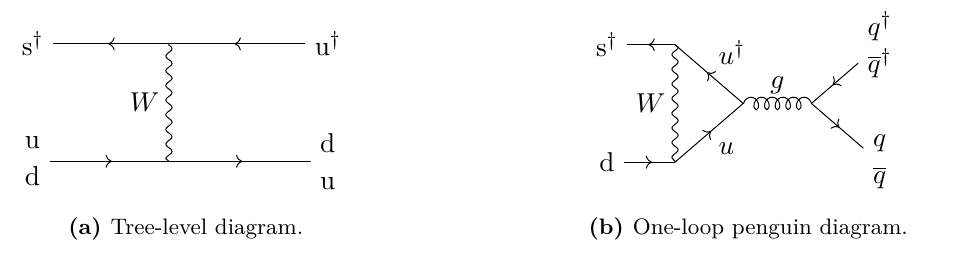
Figure 4. Processes that generate higher dimensional operators at the strong scale with four quarks. The tree level diagram a generates the operators O diagram in b generates the operators O denoted by u = u, c,